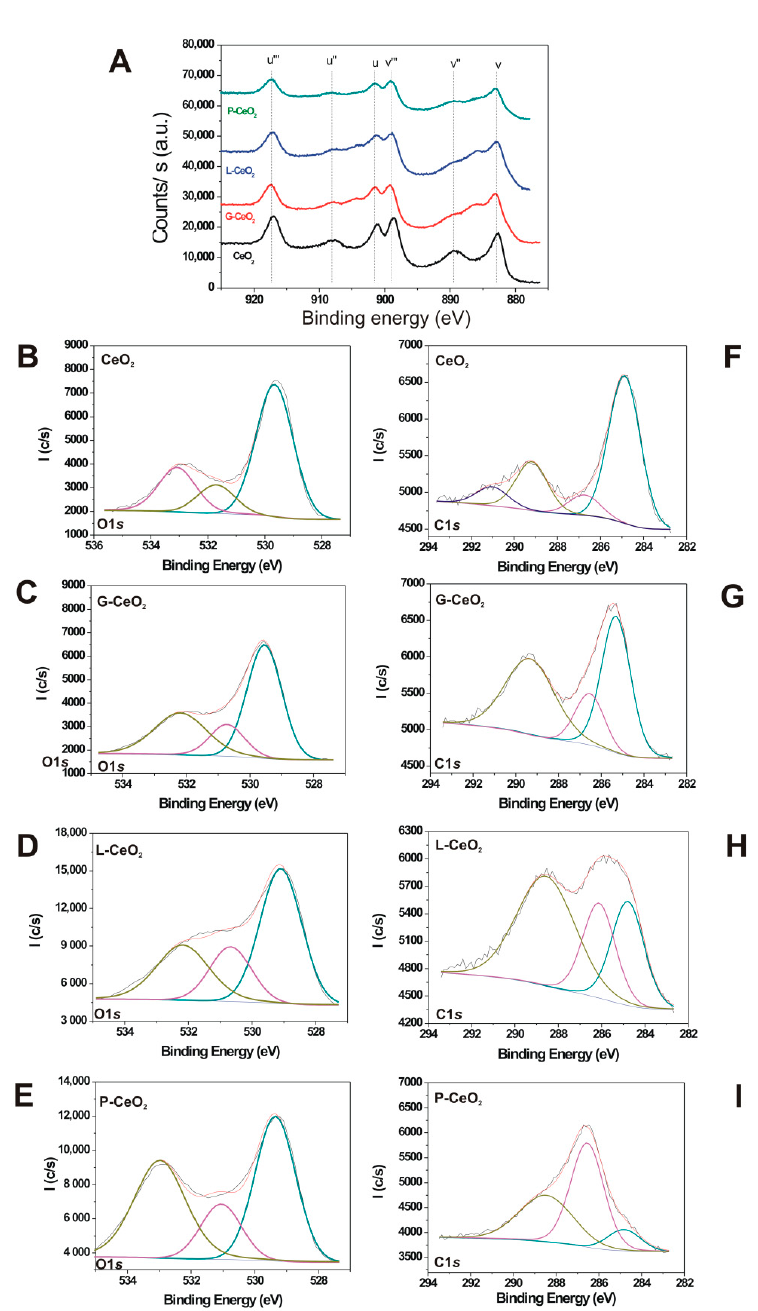
Figure 3. High-resolution X-ray photoelectron spectroscopy (XPS) spectra for the uncoated nCeO 2 and coated nanoparticles: Ce 3 d (A) , O 1 s for CeO 2 (B), G-CeO 2 (C), L-CeO 2 (D) and P-CeO 2 (E) and C 1 s core level spectra for CeO 2 (F), G-CeO 2 (G), L-CeO 2 (H) and P-CeO 2 (I). The different colors show the assignment of different core levels.